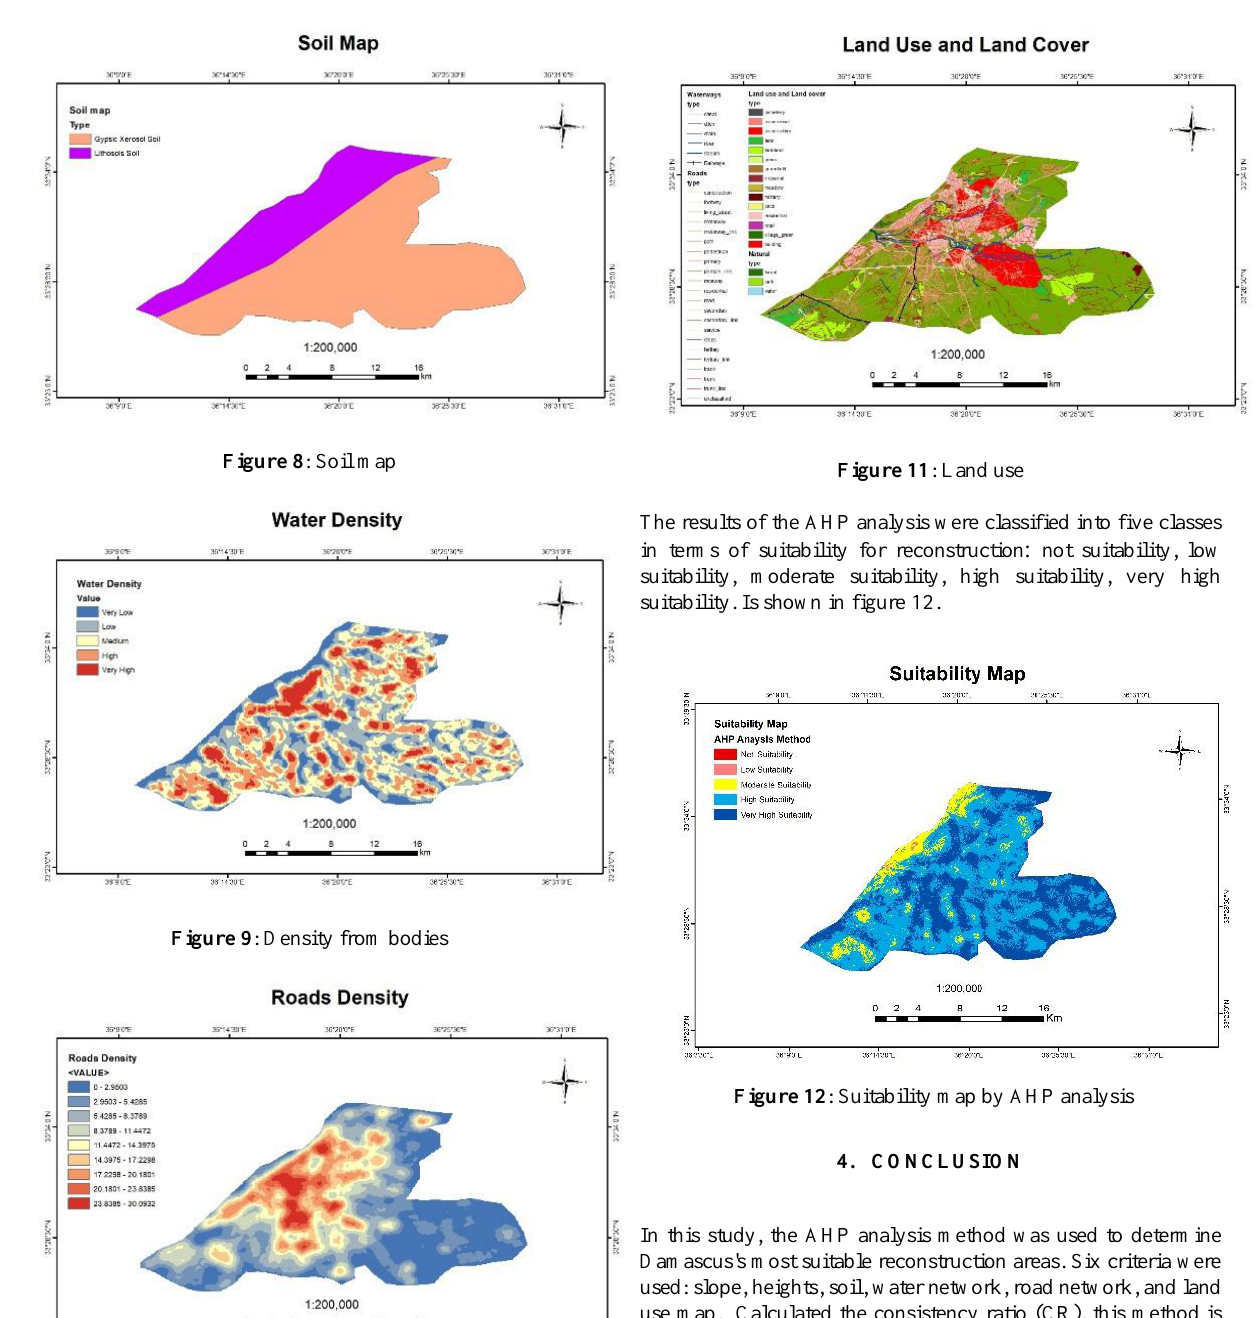
Figure 12 : Suitability map by AHP